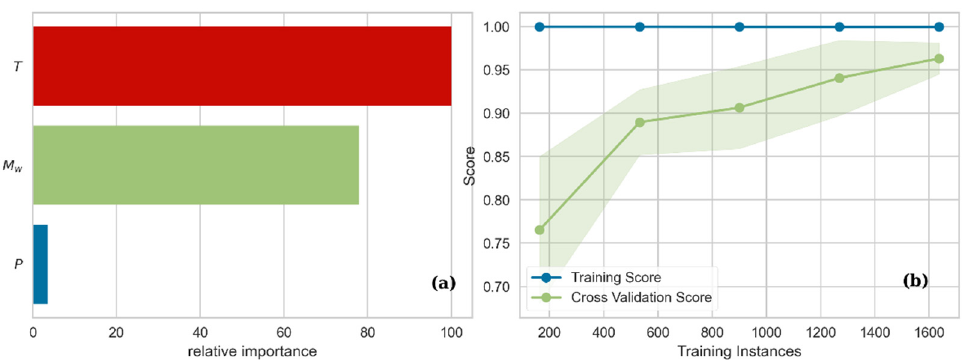
Figure 7. Interpretation output diagrams from the application of GBR algorithm on the prediction of electrical conductivity: ( a ) feature importance plot; ( b ) learning curve diagram.